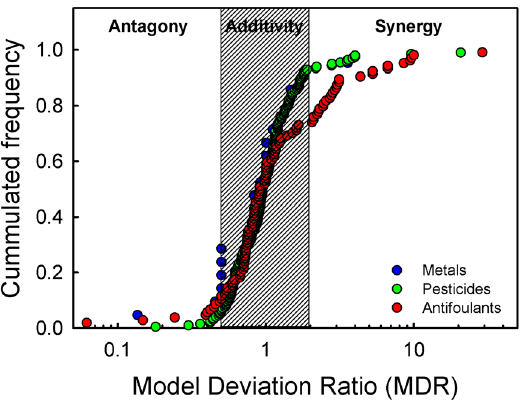
Figure 2. Cummulated frequency of Model Deviation Ratios. Cummulated frequency of Model Deviation Ratios. (MDR) of binary mixtures of pesticides ( n =195), metals ( n =20), and antifoulants ( n =103). The hatched interval where 0.5 # MDR # 2 defines the mixtures that deviates less than two-fold from a Concentration Addition predictions. Mixtures having MDR values , 0.5 are termed antagonistic,